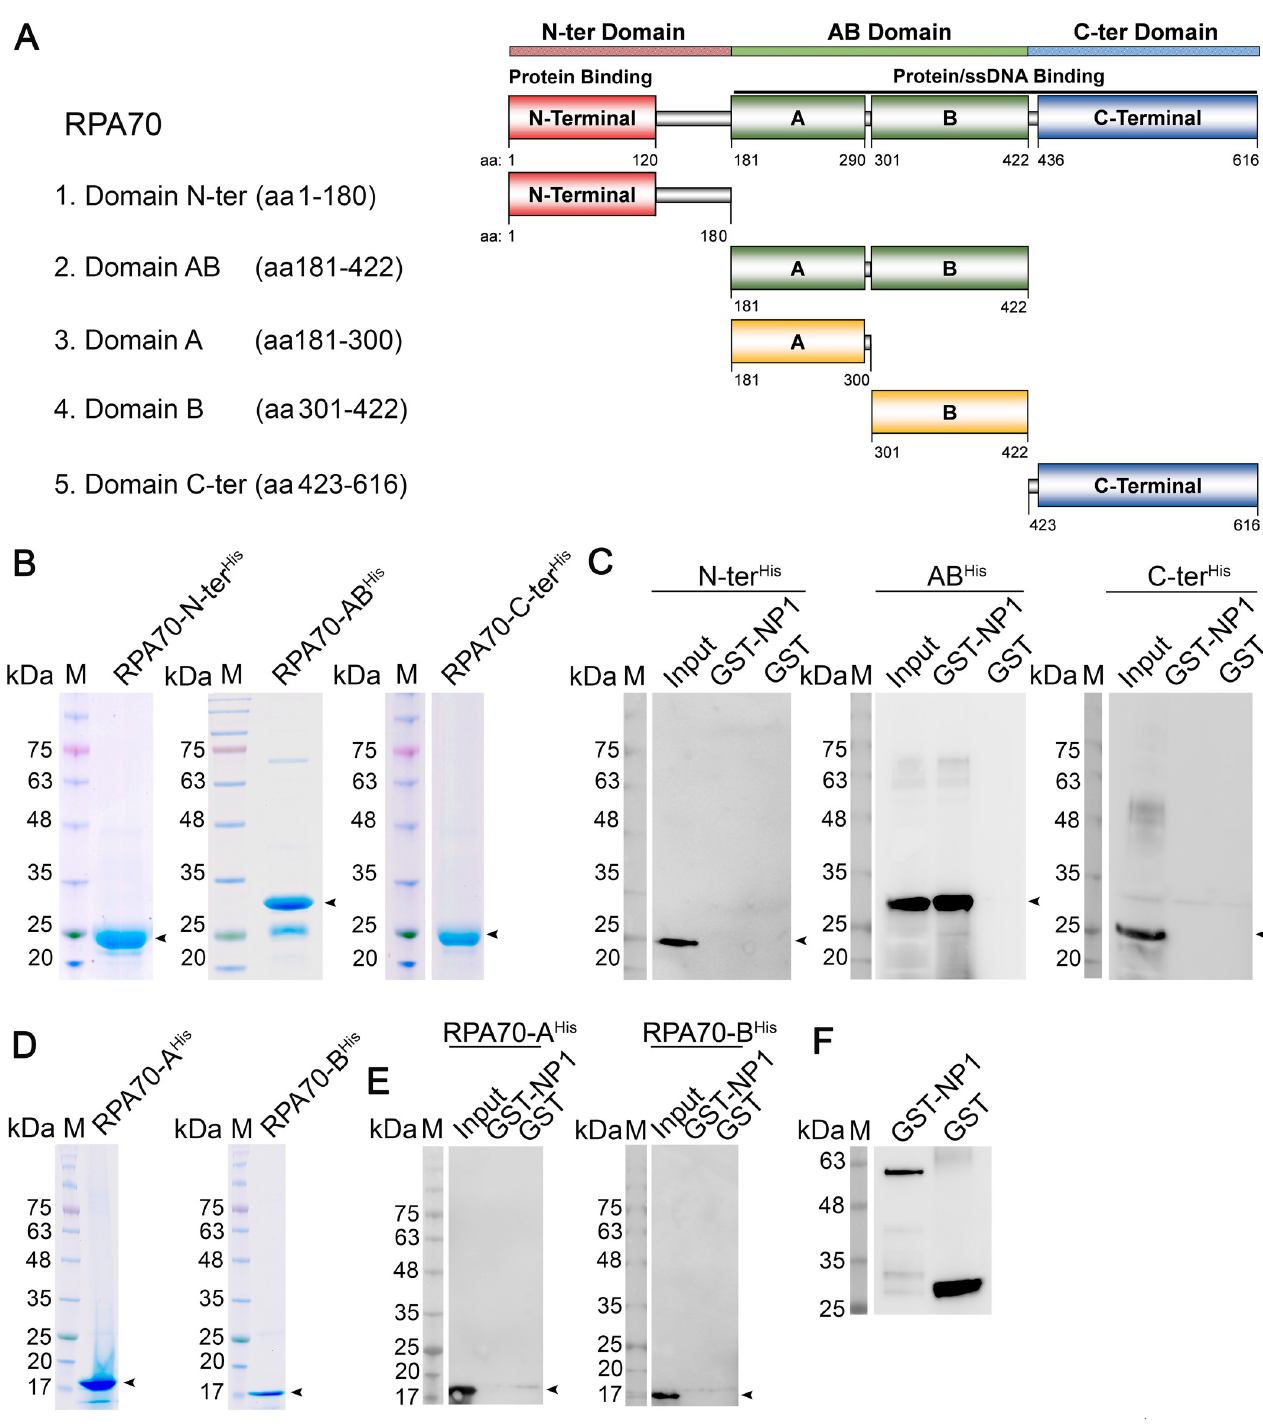
Fig 7. RPA70-AB domain directly interacts with HBoV1. (A) A diagram of RPA70 domains. The RPA70 N-terminal domain (RPA70-N-ter), AB domain (RPA70-AB), subdomains A and B within AB domain, C-terminal domain (RPA70-C-ter), and Linkers are diagrammed and shown in different colors. AB domin and C-terminus have both protein and ssDNA binding capability, while the C-terminus mediates heterodimerization with RPA32. ( B&D) Protein purification. All purified truncated domains of RPA70, RPA70-N-ter, RPA70-AB, RPA70-C-ter, RPA70-A, and RPA70-B domains, indicated by arrowheads, were analyzed on SDS-(4–20%)PAGE gel. ( C, E&F ) In vitro pull-down assays . 4 μ g of purified GST-NP1 or GST were used to pull down 4 μ g of purified domains, as indicated, using Glutathione agarose. Pulldown proteins were analyzed by Western blotting with an anti-His antibody (C&E) or with anti-GST as a control (F). Arrowheads denote the interacting